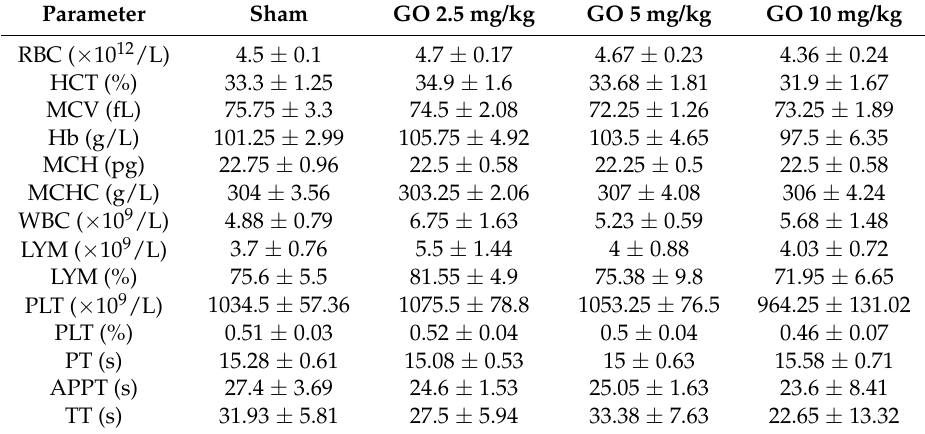
Table 5. Routine blood indexes of rats following injection of GO in the seven-day subchronic toxicity study.